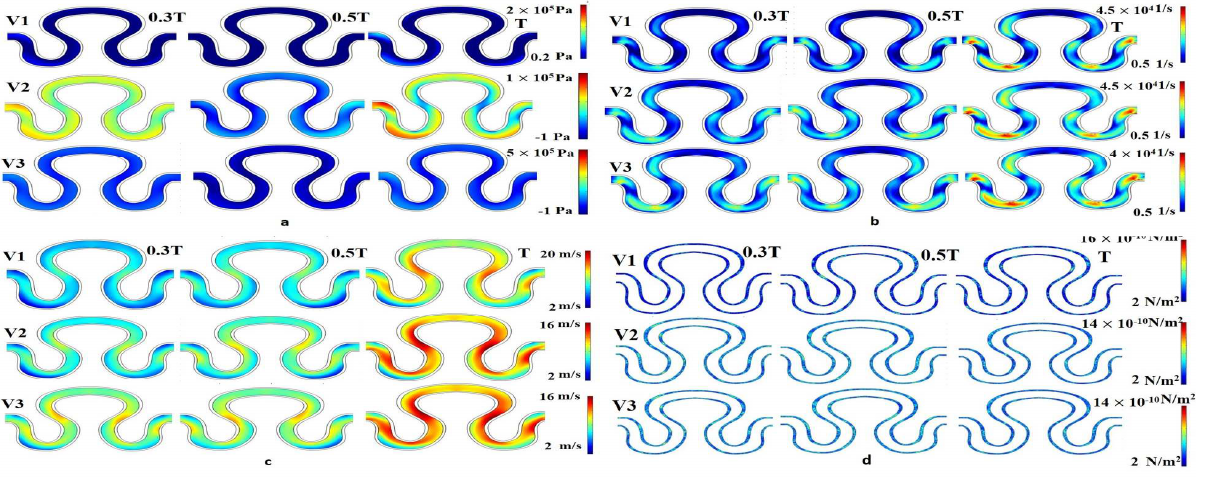
Figure 6. Contour Plot of ( a ) pressure, ( b ) shear rate, ( c ) axial velocity, ( d ) wall stress for sinusoidal flow, slip wall boundary condition for velocity models V 1 , V 2 and V 3 .